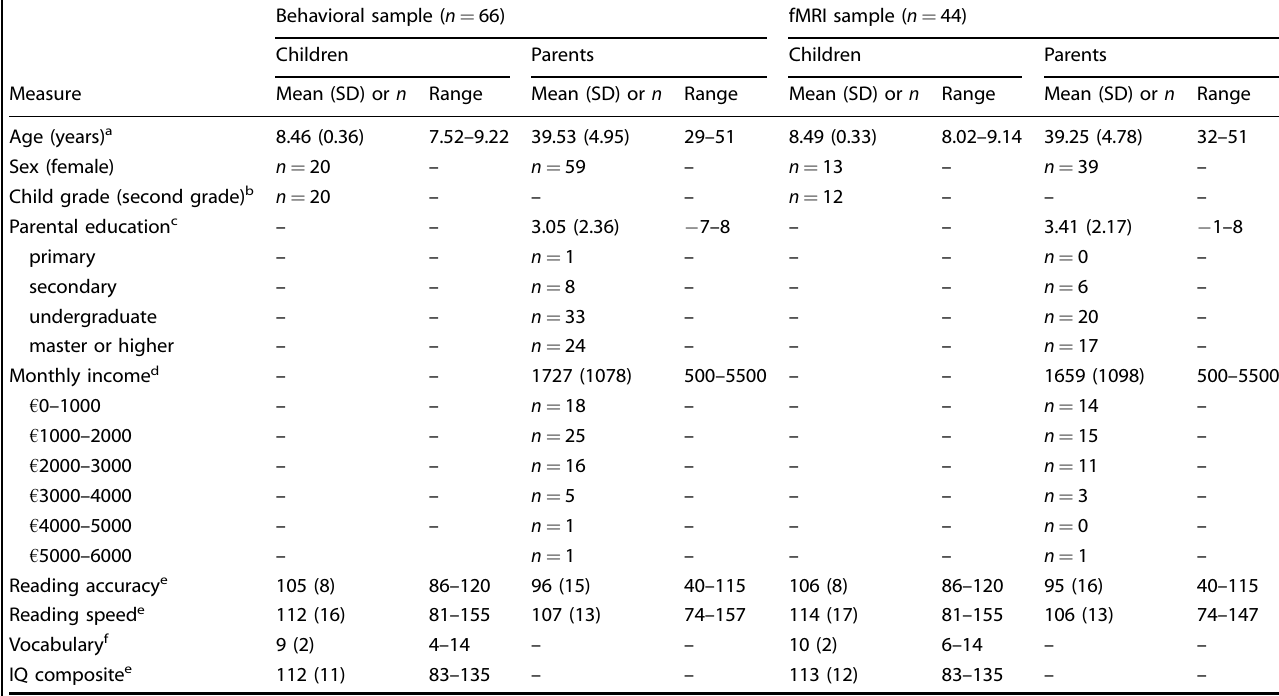
Table 1. Demographic information and test scores of children and